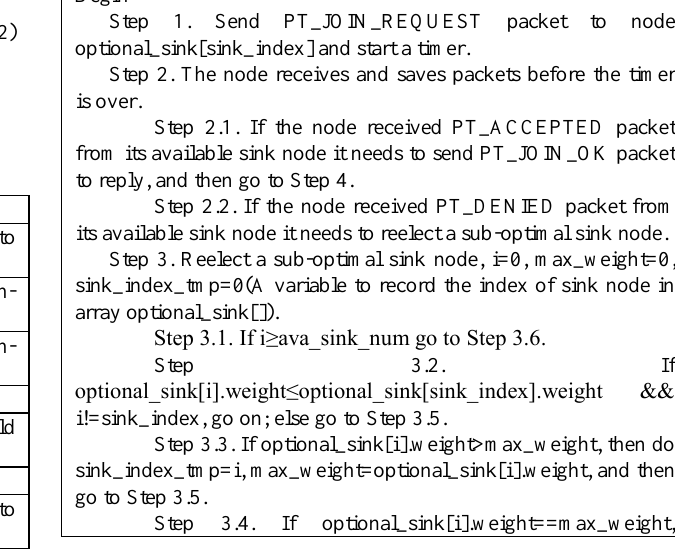
Algorithm 1. Non-network node requests join in